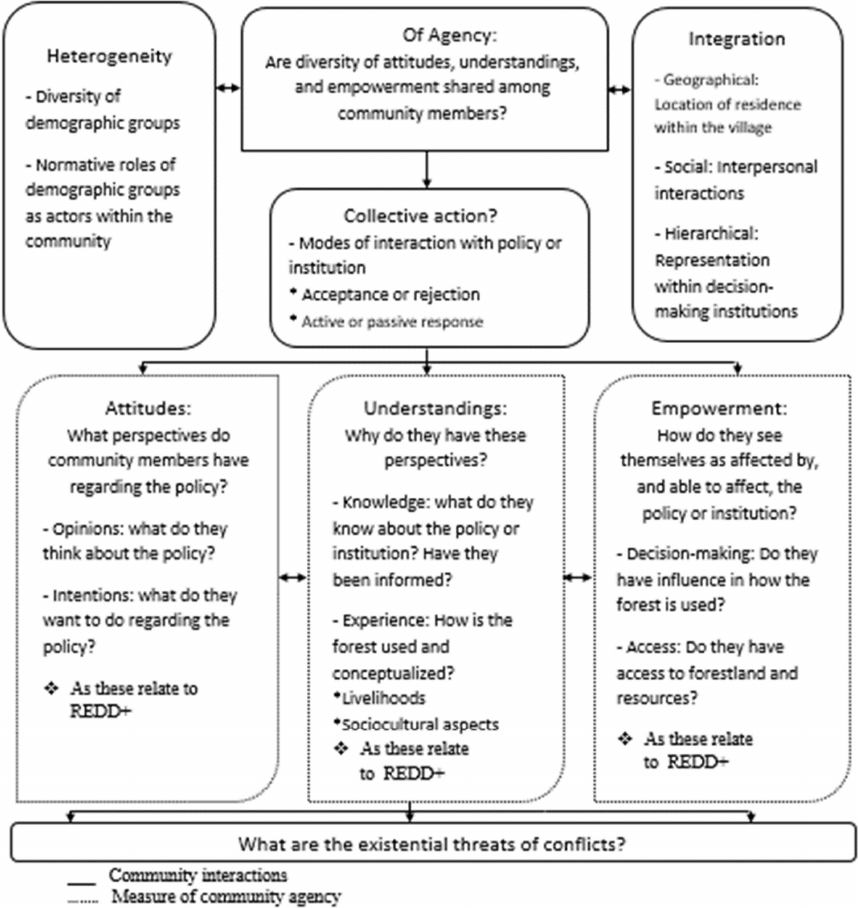
Figure 1. Concept map for the study.